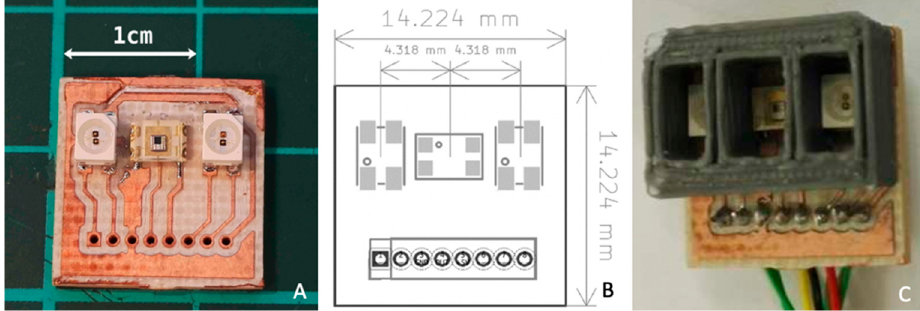
Figure 5. ( A ) Reflectance optode, ( B ) Inter-optode dimensions ( C ) Position of the optical 3 mm barrier (cm: centimeter; mm: millimeter).